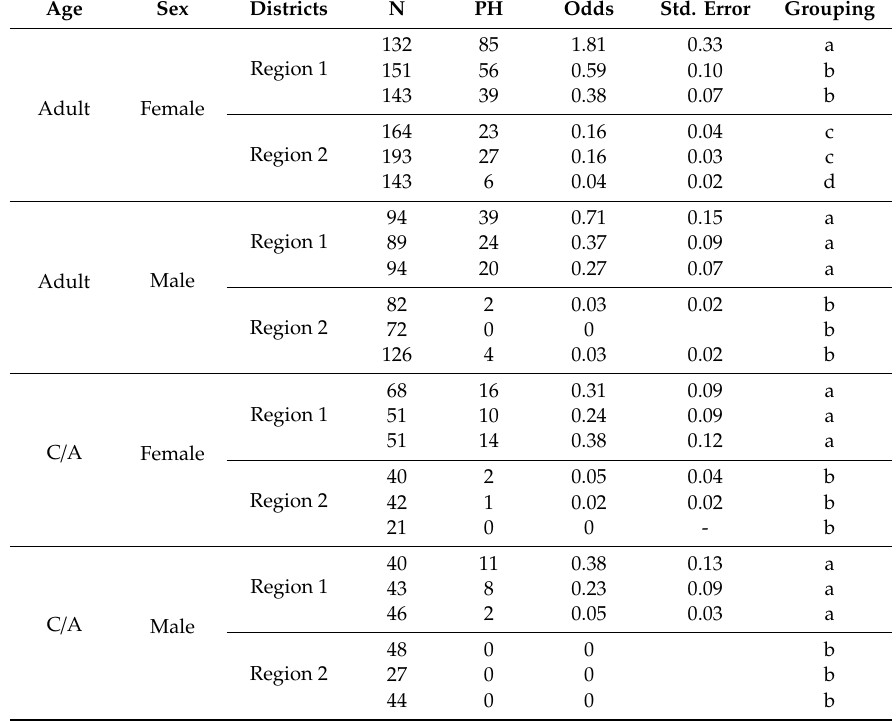
Table 1. Frequencies of residents (N), primary hypothyroidism (PH), odds of PH, and standard errors according to the multiple comparison procedure in adults, and children and adolescents (C / A) in Region 1 and Region